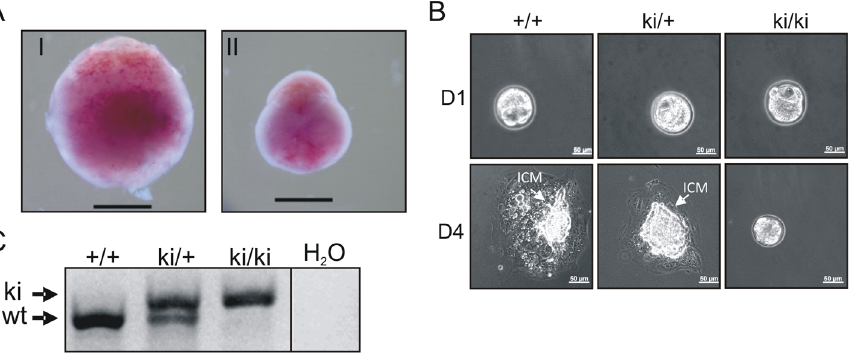
Figure 2. Inactivation of the AAD results in early embryonic developmental defects. ( A ) Decidua at E11.5 from intercrossing of TopBP1 ki/ + mice. Decidua in (I) was genotype ki/ + . Decidua in (II) was empty, thus with unclear genotype. Bar=1 mm. ( B ) Cultures of E3.5 blastocysts from TopBP1 ki/ + intercrosses.D1:1 day after culture, D4: 4 daysafter culture. Arrows indicate inner cell mass(ICM). Bar=50micrometers.Genotypes are indicated on thetop of respective images. ( C ) Example of PCR genotyping from ICM of blastocyst outgrowth. Expected product size for alleles labeled. ki=knock-in; wt=wild type.